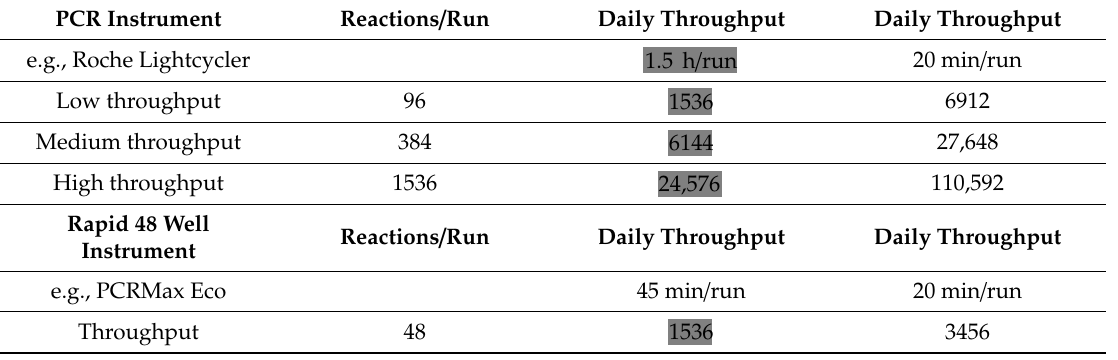
Table 2. Maximum capacity of a single qPCR instrument, assuming it is run for 24 h a day. A. A typical diagnostic instrument such as the Roche Lightcycler. B. An extremely fast research qPCR instrument with 48 wells (PCRMax Eco). This instrument stands out as it is one of the fastest qPCR systems available and typical research qPCR systems do not perform like this. More typical research qPCR systems include the Biorad CFX systems, Applied Biosystems StepOnePlus / QuantStudios, etc. All